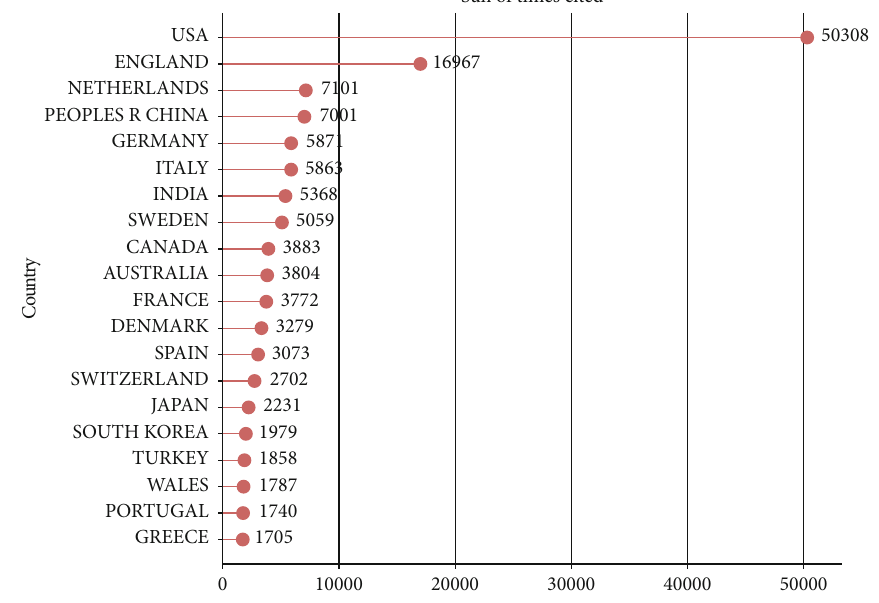
Figure 6: Top 20 countries of total